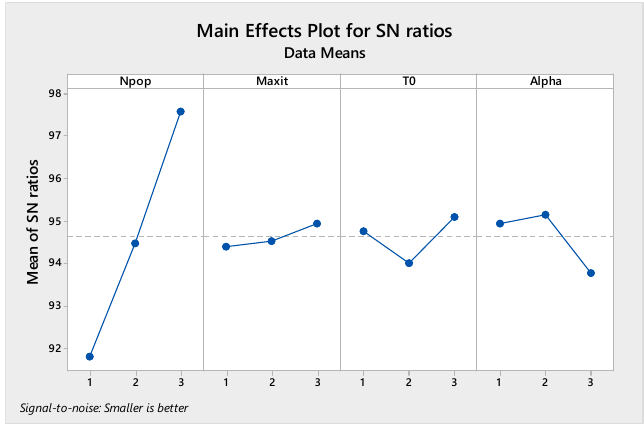
Figure 14. Signal to noise plot of MOSA.